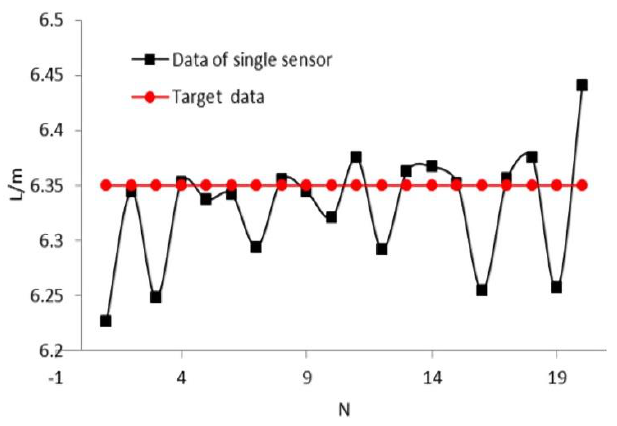
Figure 14. Experimental results of single sensor application.